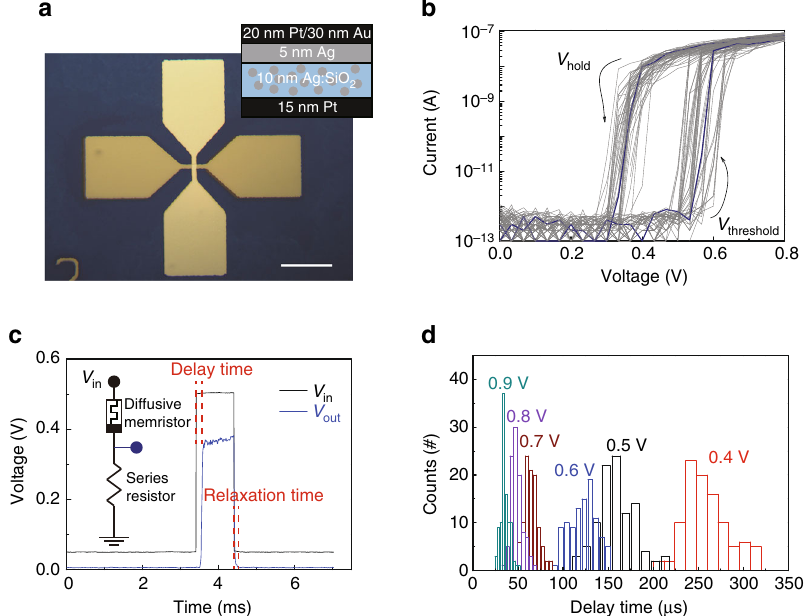
Fig. 1 Stochastic threshold switching behavior in a Ag:SiO 2 based diffusive memristor. a Optical microscopic image of the 5 × 5 µ m 2 Ag:SiO 2 cross-point device. Scale bar , 50 µ m. Inset shows geometry of the Ag:SiO 2 diffusive memristor. Note that a 5 nm Ag layer is inserted between switching layer and top electrode to provide enough Ag supply. b 50 Consecutive DC switching cycles of the diffusive memristor connected to a 4.7 M Ω series resistor. c Typical pulse switching behavior of the diffusive memristor. Under a voltage pulse (300 µ s in this case), some delay time is needed before the device abruptly turns ON. Inset shows the circuit for the measurements with a 120 k Ω resistor connected in series to the memristor. d Distribution of delay time for different input pulse amplitude (0.4 to 0.9 V at 50 Hz). A higher voltage leads to a shorter average delay time with a narrower